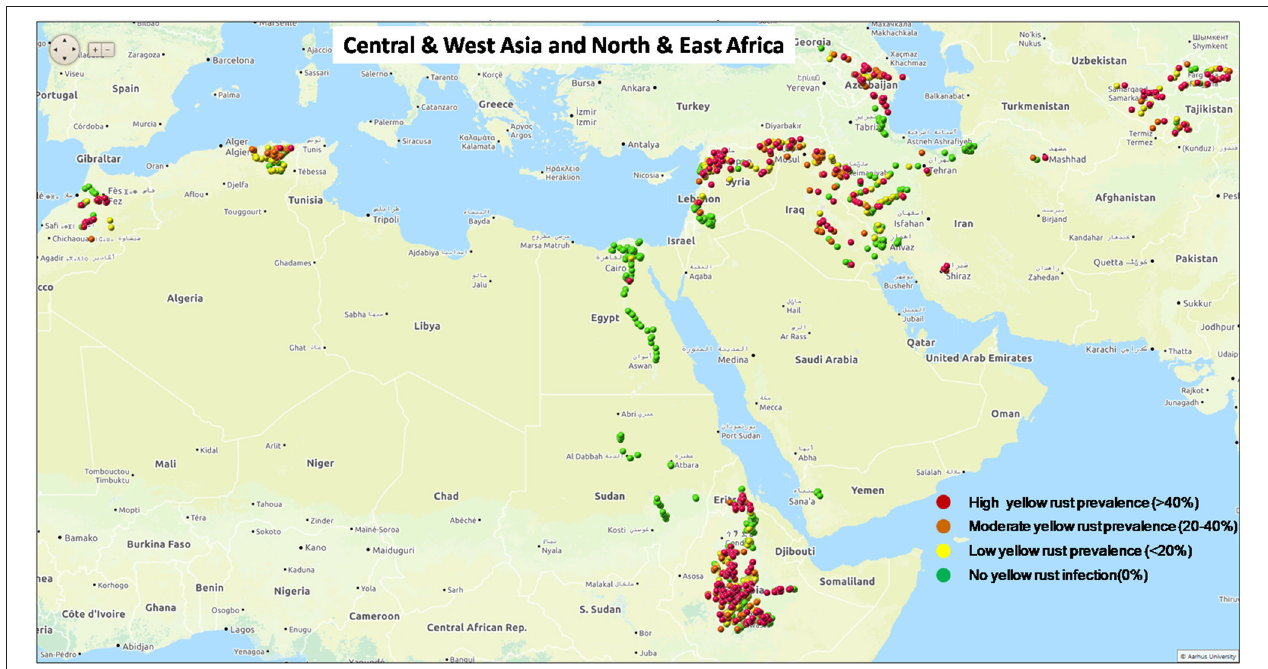
FIGURE 1 | Status of yellow rust prevalence in Central and West Asia and East and North Africa in the 2010 epidemics